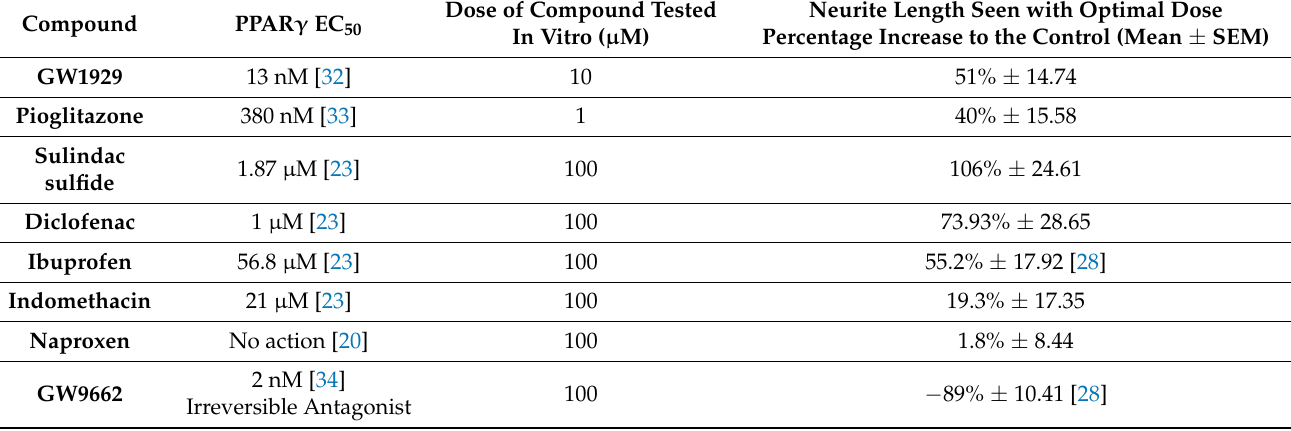
Table 1. The ranking order of an agonist’s EC 50 for PPAR γ and neurite length increase in